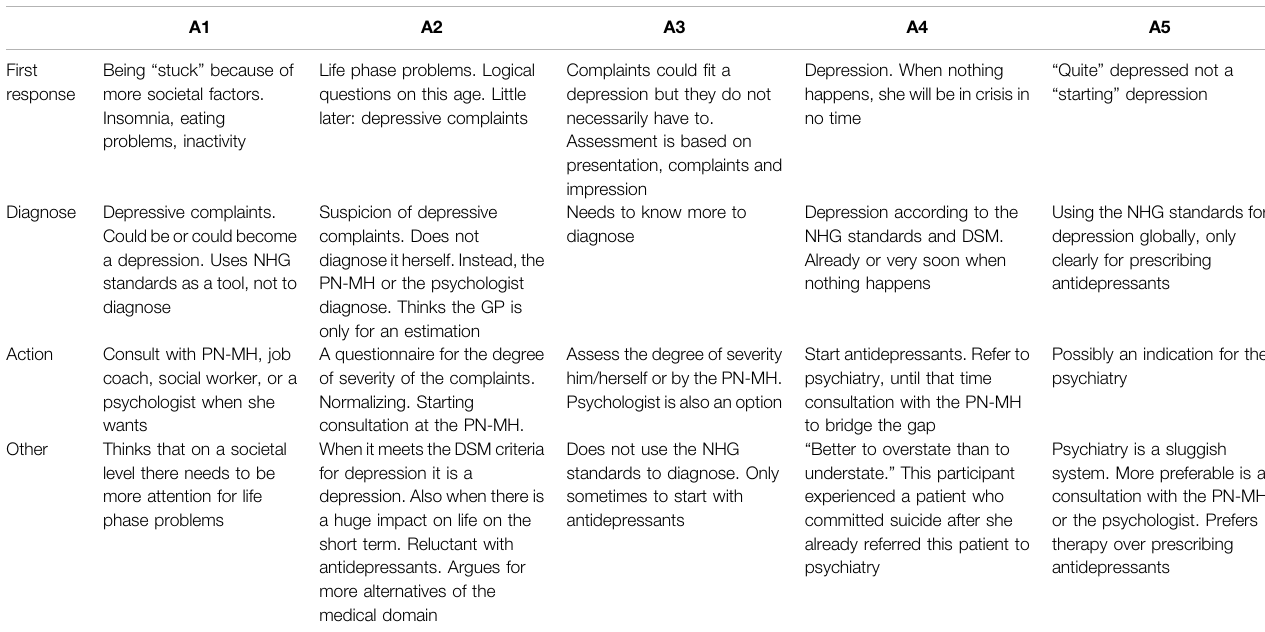
TABLE 3 | Alumni ’ s assessment and intervention.